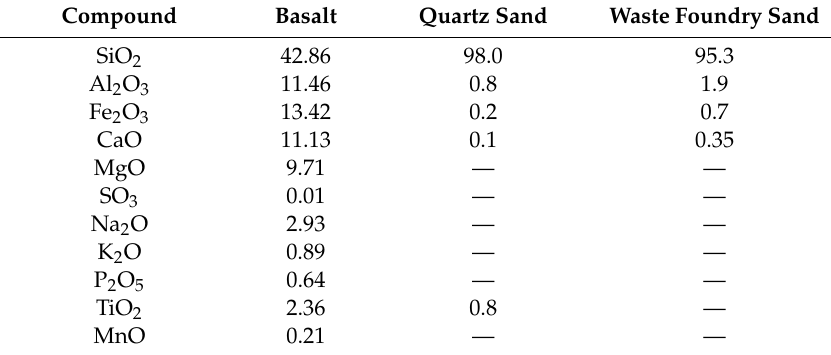
Table 4. Chemical composition of basalt aggregate, quartz sand and WFS (in